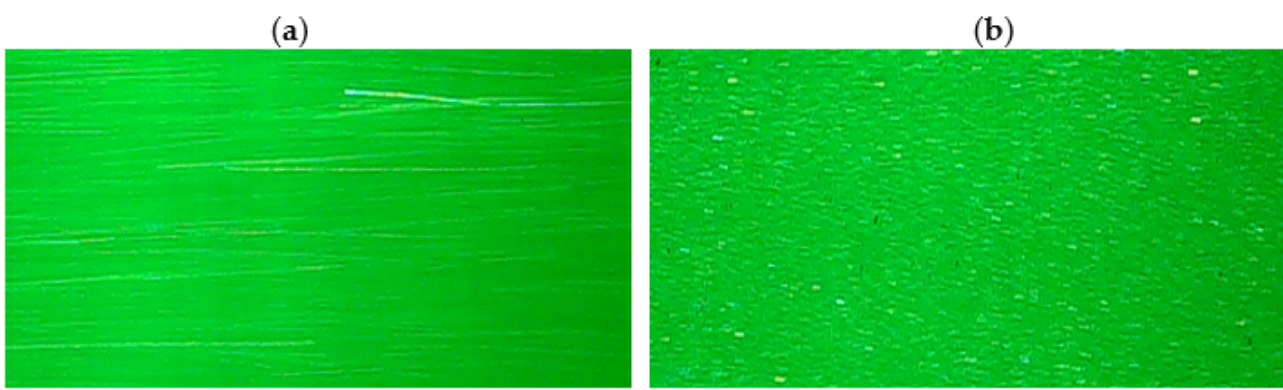
Figure 12. Sample images of registered trace markers for ( a ) exposure time 1/10 s of particle velocity 0.799 m/s, ( b ) exposure time 1/50 s of particle velocity 0.047 m/s.